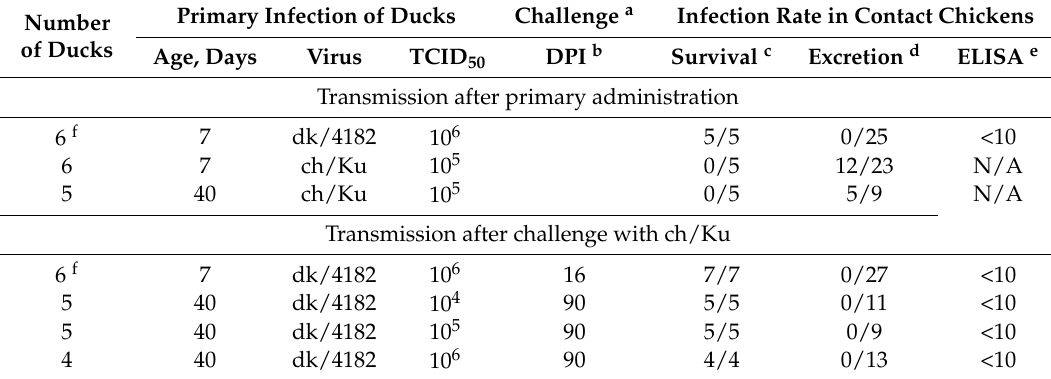
Table 3. Survival, fecal excretion of the virus and antibody responses in chickens that contacted the ducks primarily infected with dk/4182 or